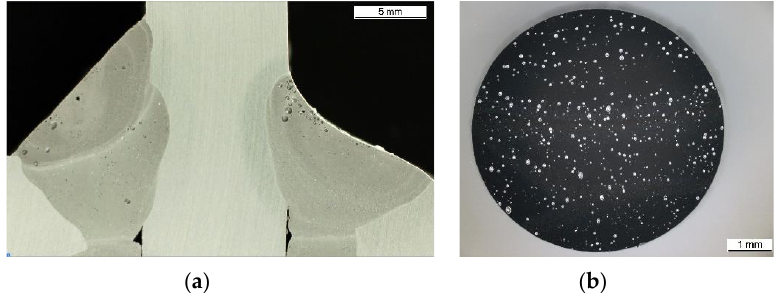
Figure 21. Cross section of ( a ) an X-profile and ( b ) a tensile specimen of the FZ material [34].